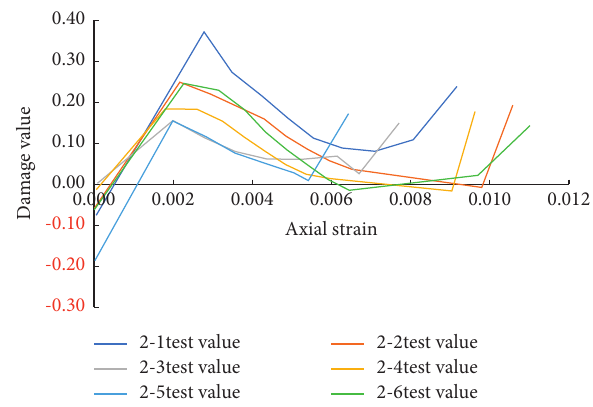
Figure 7: D − ε test curve of filled cracked rocks with cement mortar. 1 t